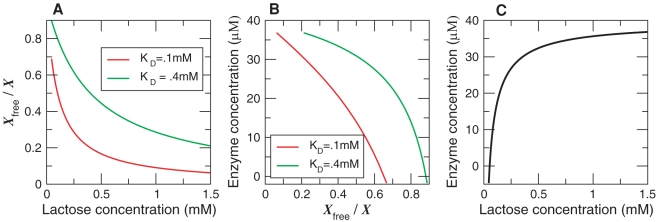
Different Regulatory Networks Can Yield the Same Optimal Enzyme Expression Level as a Function of Inducer Concentration.This is illustrated for two regulatory networks of the lac system, which differ in the dissociation constants of lactose-repressor binding and repressor-operator binding. Panels (A) and (B) show the response functions at two different stages of the lac regulatory network, while panel (C) shows the resulting optimal enzyme expression level as a function of lactose concentration. (A) The fraction of repressor that is not bound by lactose, X
free/X, as a function of lactose concentration for two different lactose-repressor binding constants. (B) The corresponding response curves of the enzyme expression level as a function of the fraction of free repressor. The total expression level of repressor is chosen to correspond to the optimal growth rate (see Figure 2). (C) The resulting optimal enzyme expression level as a function of the lactose concentration, as predicted by Equation 20 [12].